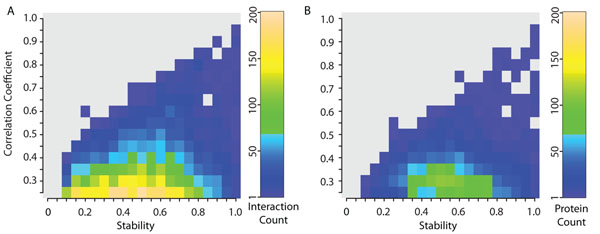
Distribution of interactions and proteins over co-expression correlation and stability. Number of a) interactions and b) proteins in the human protein-protein interaction network within ranges of co-expression correlation coefficient and stability as indicated in the heat map. The values for interactions are those of the gene pairs of interacting proteins. The values for proteins are averaged across all the interactions they participate in. The absence of proteins or interactions (0 value) is indicated in gray in the heat map to allow for better visualization of outliers. The correlation between co-expression correlation and stability is low showing their independence as sources of information.